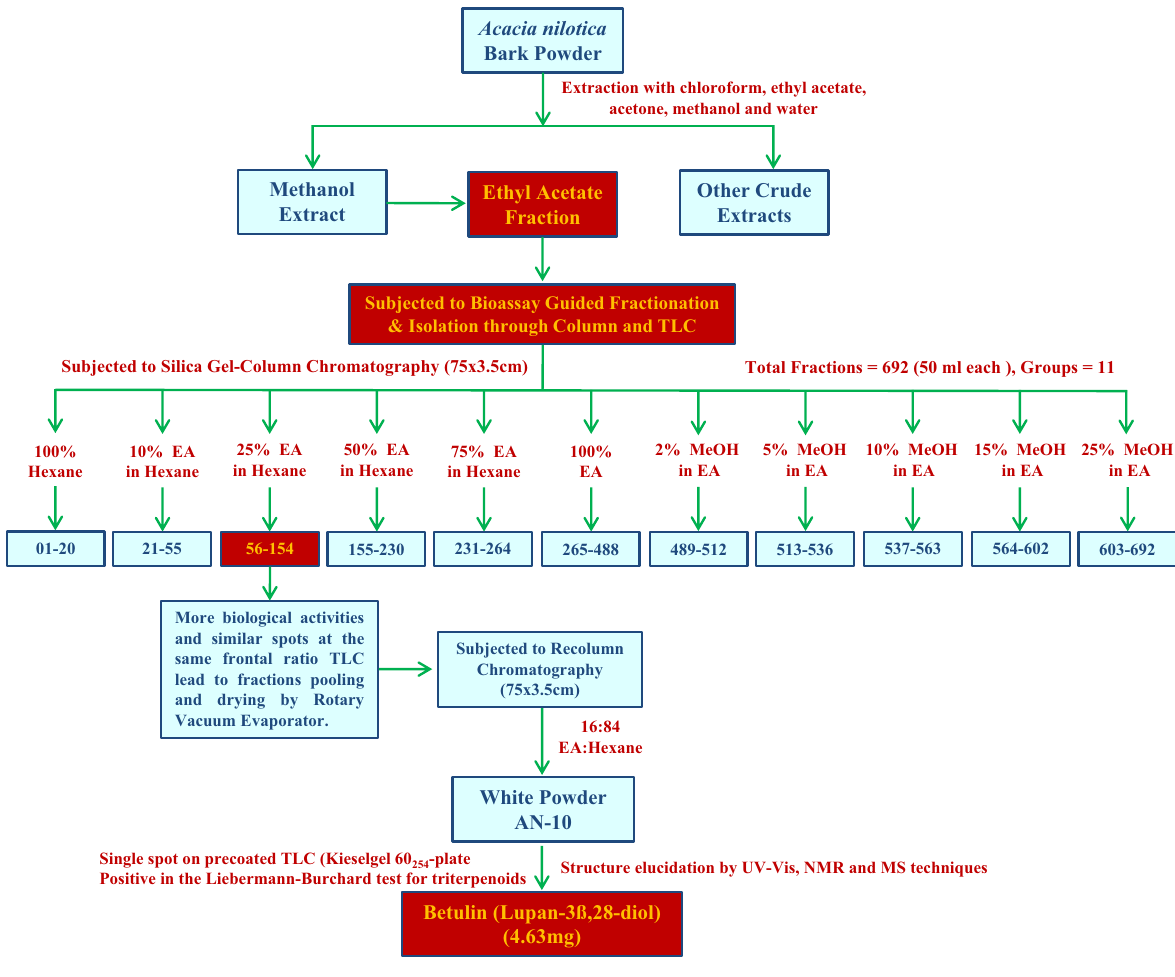
Figure 2. Bioassay guided fractionation and isolation of triterpenoids from ethyl acetate fraction of methanol extract of Acacia nilotica bark